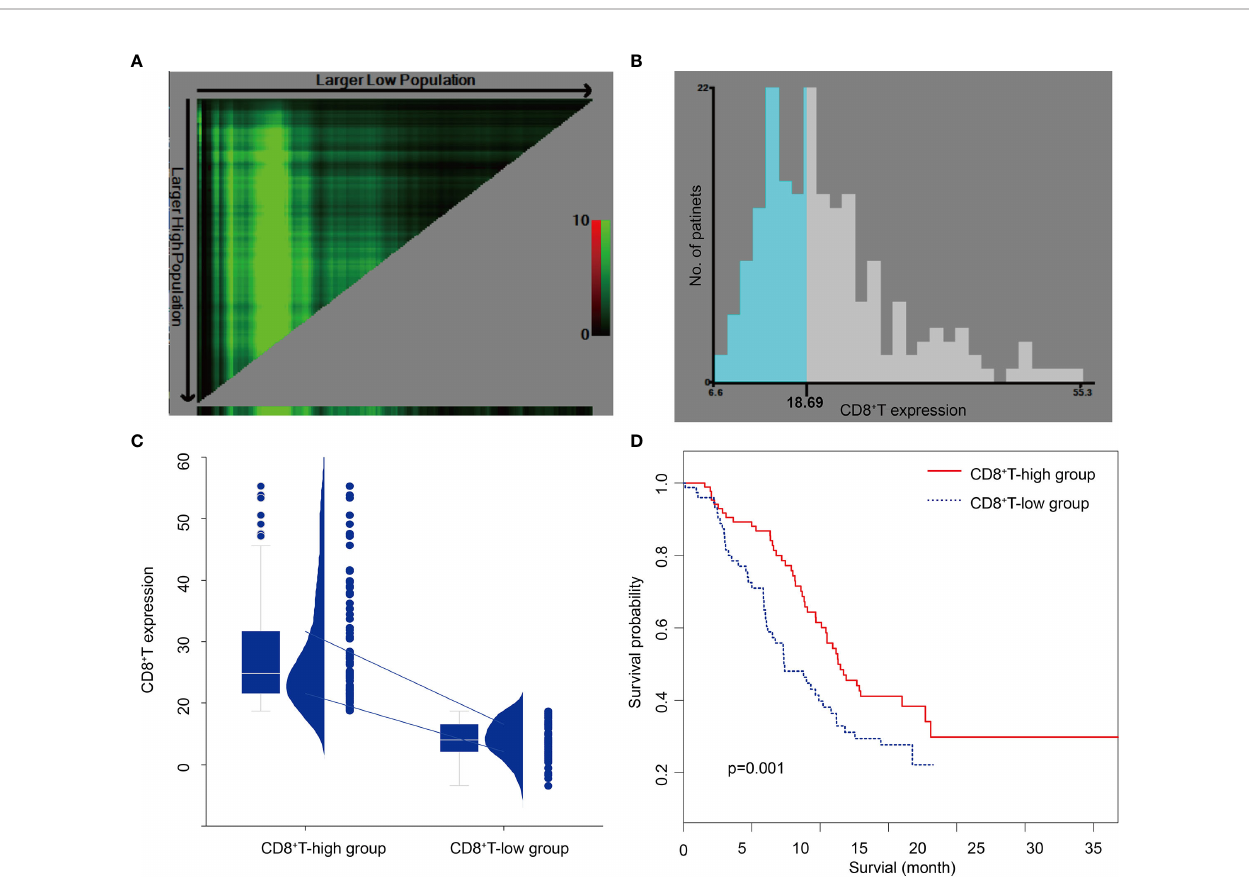
FIGURE 3 | X-tile analysis of survival data in patients with pancreatic ductal adenocarcinoma (A, B) The optimal cut-off CD8 + T-cell level of 18.69%, determined by X-tile, is used to de fi ne the CD8 + T-high and CD8 + T-low groups. (C) CD8 + T in the CD8 + T-low group and the CD8 + T-high group. The chart includes a box plot, density plot, and dot plot. The 25th and 75th percentiles are shown as connecting lines between groups. (D) The Kaplan-Meier curve and log-rank test suggest that patients in the CD8 + T-high group survive signi fi cantly longer than those in the CD8 + T-low